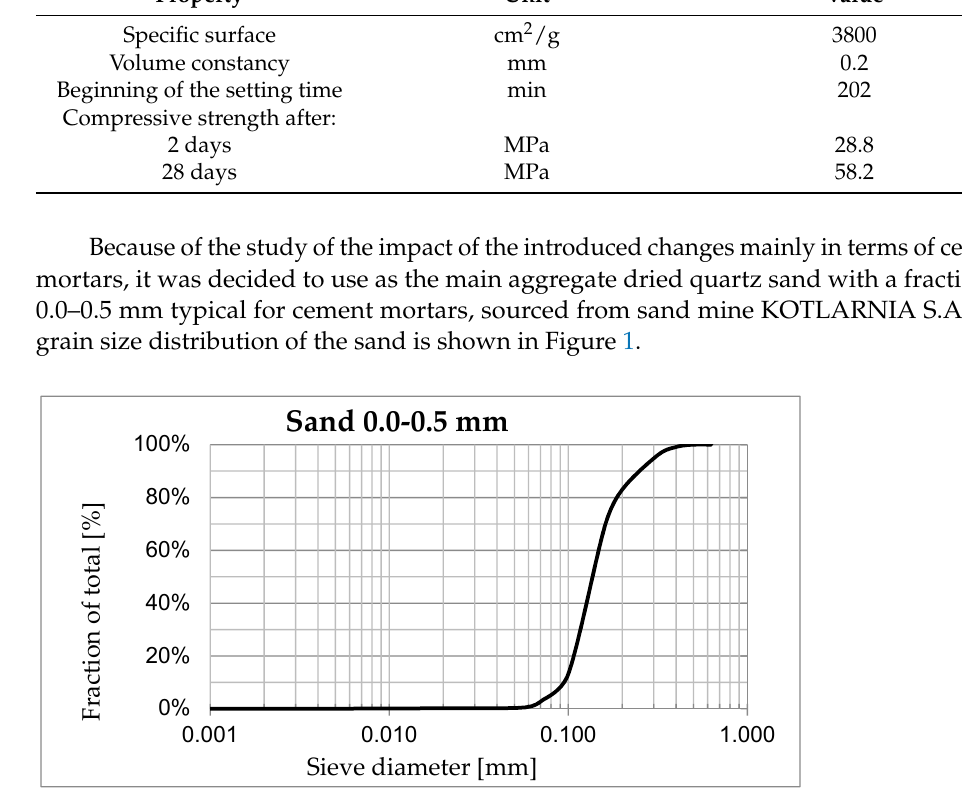
Figure 1. Particle size distribution of aggregates.